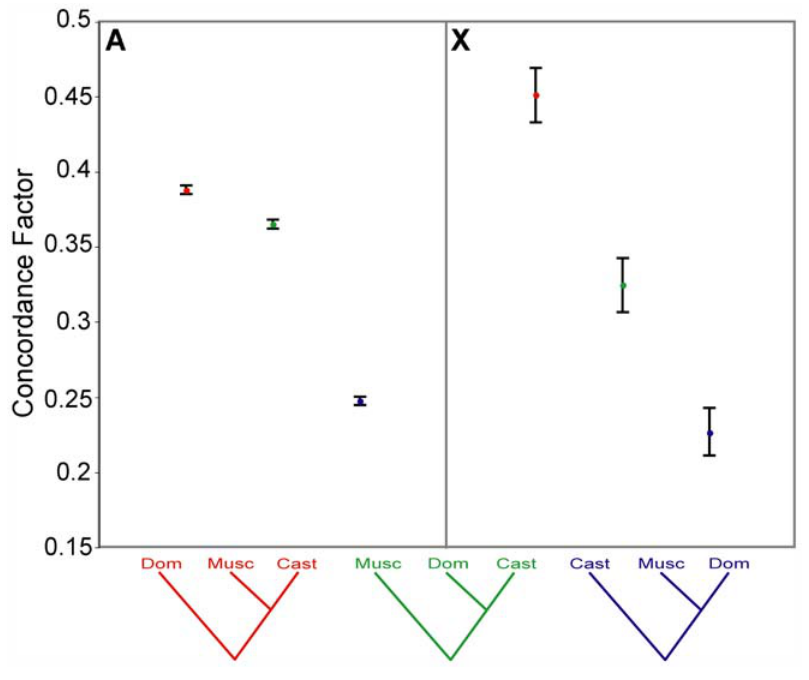
Figure 4. Phylogenetic discordance between the autosomes and the X chromosome. Significantly less discordance is observed across loci of the X chromosome (X: 442 loci) than the autosomes (A: 13,639 loci). This is shown by significantly higher support for the primary phylogenetic history, the M. m. musculus/M. m. castaneus topology, at the expense of loci supporting the other two topologies. Colors correspond to the three topologies. Error bars are 95% credibility